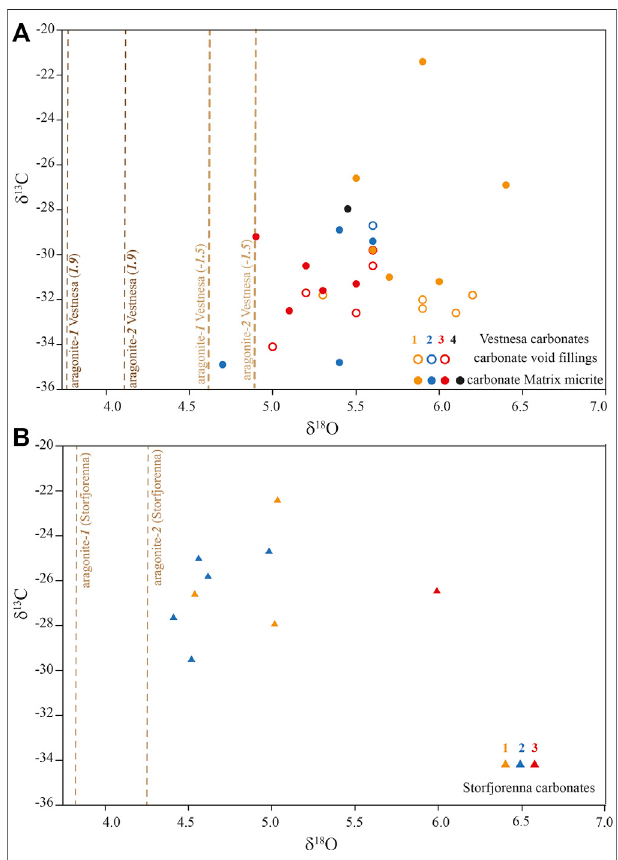
FIGURE 4 | Carbonate stable carbon and oxygen isotope compositions in (A) . Vestnesa Ridge and (B) Storfjordrenna. The dashed lines indicate the theoretical δ 18 O values of aragonite-1 (Kim et al., 2007), aragonite-2 (Grossman and Ku, 1986) expected for precipitation in equilibrium with bottom water temperature, according to Eqs. 2 and 3 , respectively. For Vestnesa, two different temperatures were assumed based on the reconstructed temperature from foraminifera (Dessandier et al.,